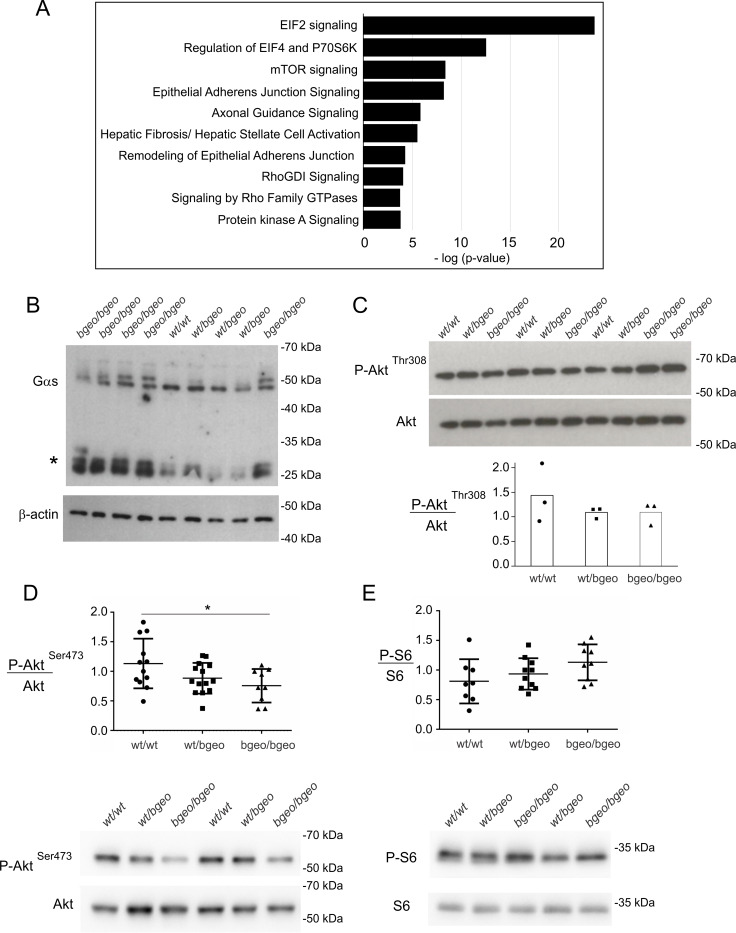
Phosphorylation of Akt (Ser473) is decreased in Ric-8Bbgeo/bgeo embryos.(A) Cell signaling pathways predicted to be altered in the Ric-8B mutant embryos. Top 10 altered signaling pathways, as predicted by IPA, are shown. The ranking was based on the p values derived from the Fisher’s exact test (IPA). The x axis displays the–(log) p value. (B) Western blot of Gαs content in E9.5 embryos from the different Ric-8B genotypes. β-actin was used as loading control. (* possible degradation products of Gαs). (C) Western blot analysis of phospho-Akt (Thr308) in E9.5 embryos compared to pan-Akt. The graph shows the quantification of the ratio of phospho-Akt (Thr308) compared to pan-Akt (D) Semi-quantitative analysis of Akt (Ser473) phosphorylation in E9.5 embryos. The graph shows the quantification of the ratio of phospho-Akt (Ser473) compared to pan-Akt. Values are expressed relative to wild type embryo levels and shown as mean +/- S.E.M. (each dot represents an embryo), *, P<0.05. A representative Western blot is shown below the graph. (E) Semi-quantitative analysis of S6 phosphorylation in E9.5 embryos. The graph shows the quantification of the ratio of phospho-S6 compared to total S6. Values are expressed relative to wild type embryo levels and shown as mean +/- S.E.M. (each dot represents an embryo). A representative Western blot is shown below the graph.